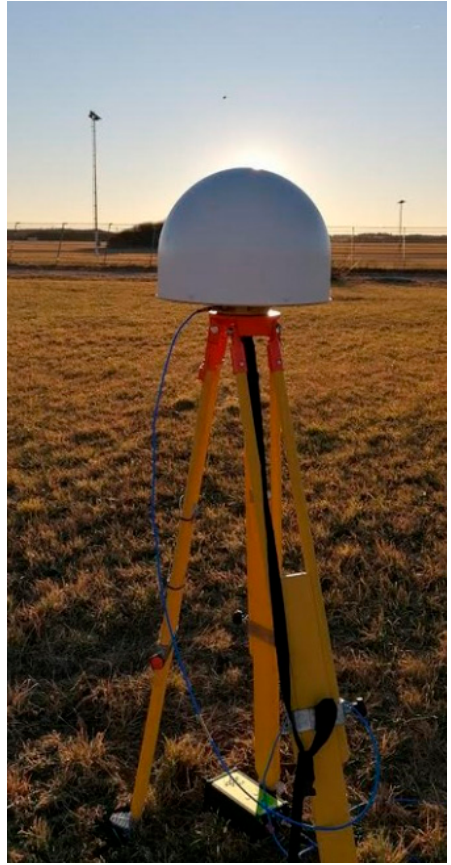
Figure 9. Leica AR25R4 antenna placed on a tripod in DLR campus field for GNSS measurement. The antennas were evaluated in terms of C/ N 0 (i.e., carrier-to-noise ratio, directly affected by the gain characteristics of the antenna) and 100 s smoothed multipath and noise errors over elevation (calculated through dual-frequency code-minus-carrier methods parison between the different antennas. Please note once more that different C/ 𝑁 (cid:2868) maxi- mum levels are mostly related to the LNAs of the antennas (i.e., passive antennas have